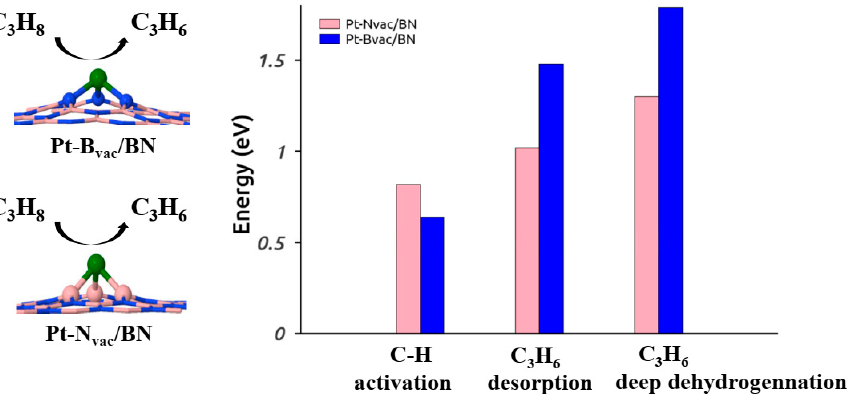
Figure 2. Comparison of energy barriers for C–H activation, C 3 H 6 desorption and deep dehydro- genation on boron (Bvac) and nitrogen (Nvac) vacancies. Reprinted with permission from ref. [24]. Copyright 2021 Elsevier